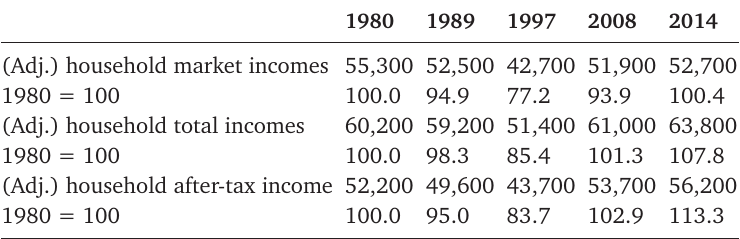
Table 2. Median household incomes (in 2015 constant dollars), adjusted for family size,